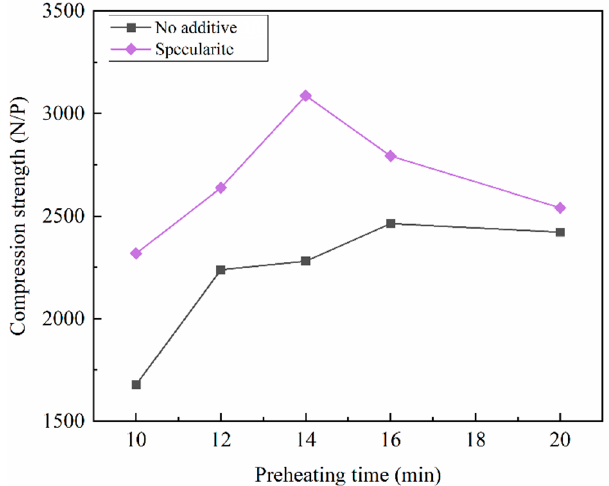
Figure 5. Effects of preheating time on compression strength of roasted pellets (preheating temper- ature 950 °C , roasting temperature 1080 °C, roasting time 10 min). ture 950 ◦ C, roasting temperature 1080 ◦ C, roasting time 10